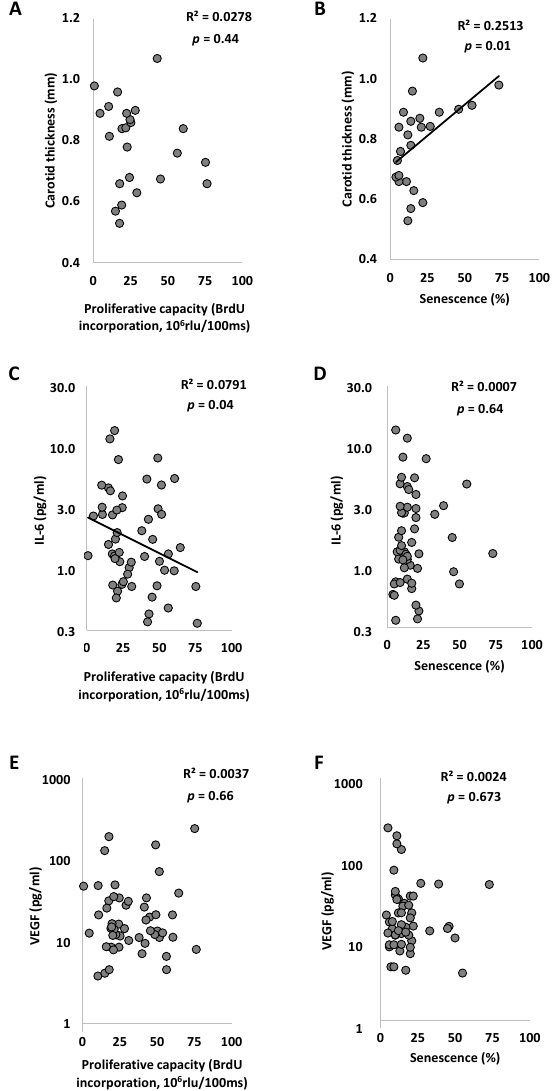
Figure 5. Relations between ECFC proliferative capacity or senescence and clinical characteristics. ( A , B ) Carotid thickness (mm) according to the proliferative capacity and the senescence of ECFC. ( C , D ) IL-6 level according to the proliferative capacity and the senescence of ECFC. ( E , F ) VEGF level according to the proliferative capacity and the senescence of ECFC. R 2 and p are from Pearson correlation. IL-6 indicates Interleukin 6 and VEGF indicates vascular endothelium growth